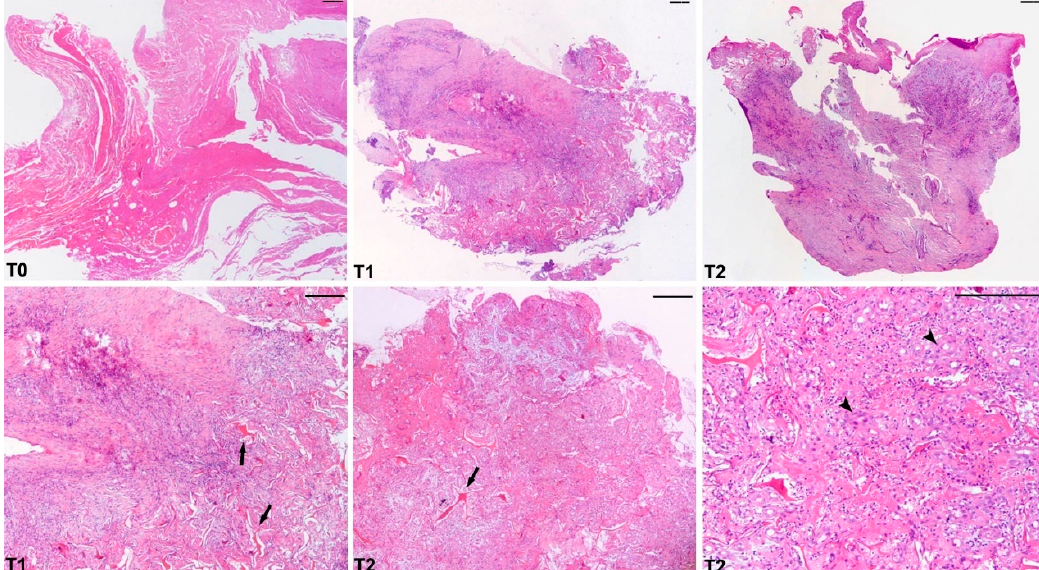
Figure 4. Microscopic aspects of wound healing and neo-angiogenesis after Nevelia ® application. Representative microscopic images of Hematoxylin & Eosin-stained paraffin sections of skin biopsies at baseline (T0) showing a typical ulcer with cellular debris. After the dermal substitute application at T1 (after two weeks) and at T2 (after three weeks), skin punch biopsies showed wound healing with re-epithelialization, dermal granulation tissue with collagen deposition and newly formed vessels (arrowheads). The presence of Nevelia ® is still evident in dermal tissue at T1 and T2 (arrows). Scale bar = 5 μ m.